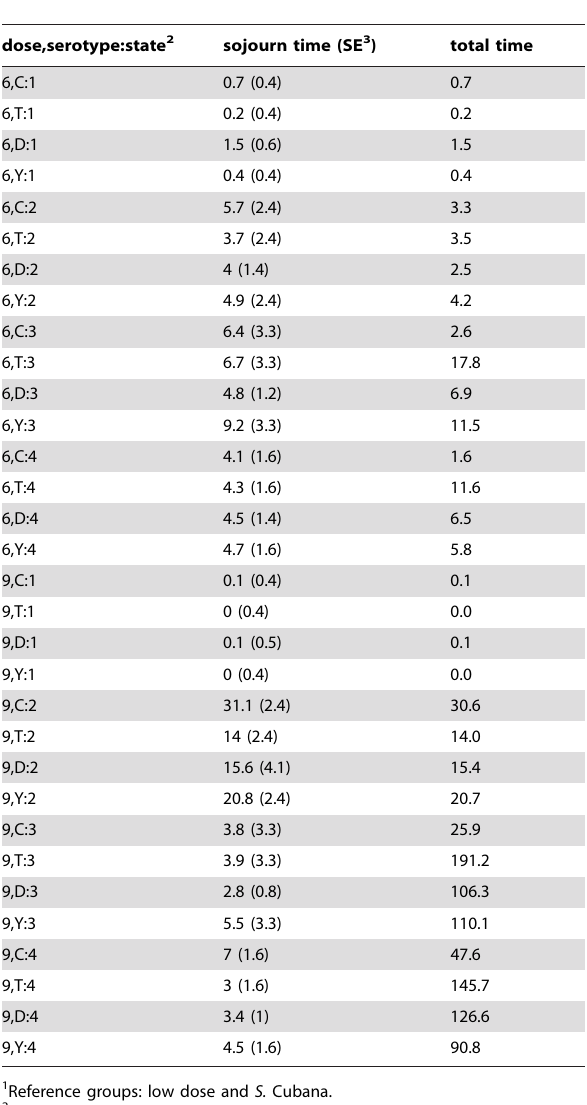
Table 1. Ratios of transition intensities out of a state in the fecal shedding model 1 .